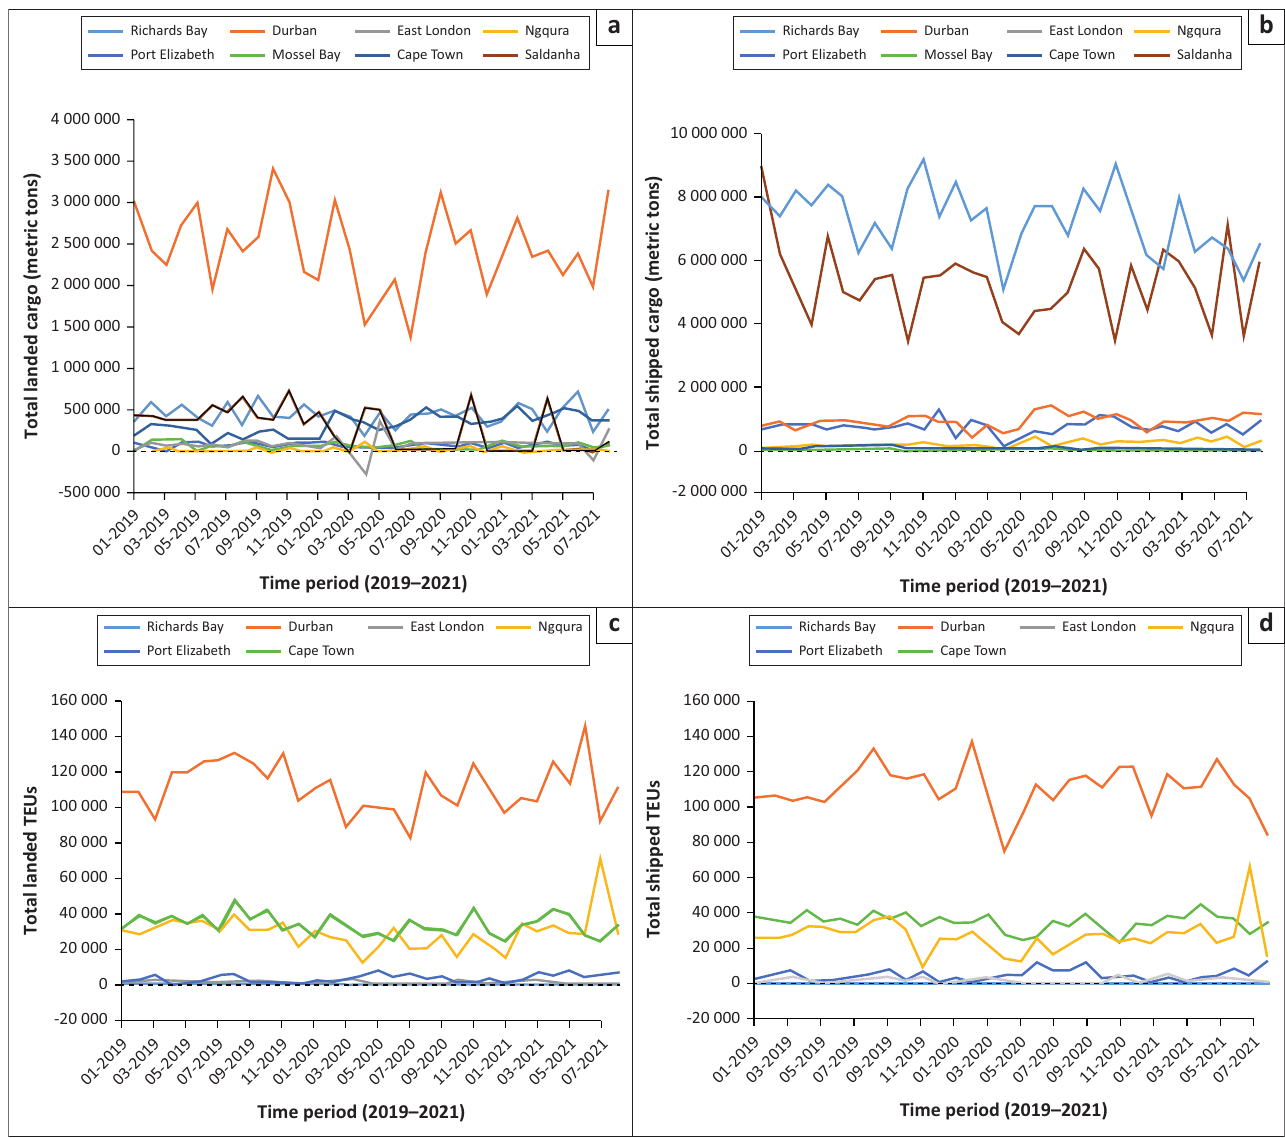
FIGURE 2: Total cargo (in metric tons) and total Twenty-foot equivalent unit (TEU) flows through South Africa’s ports.